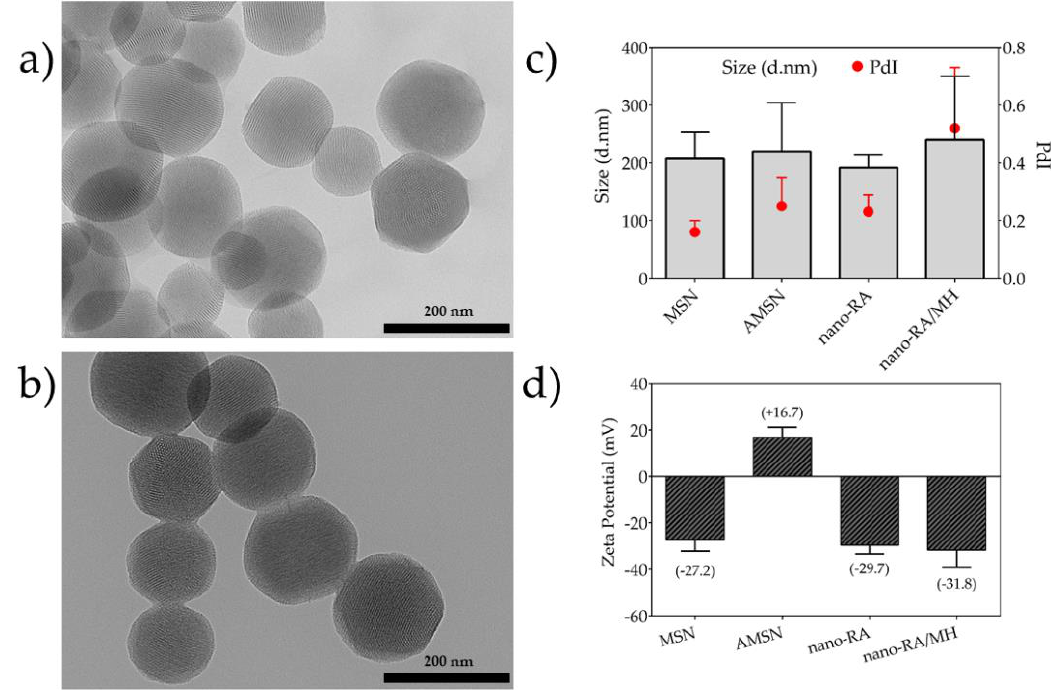
Figure 2. Transmission electron microscopy (TEM) micrographs and particle size distribution. ( a ) TEM image of bare mesoporous silica nanoparticles (MSN), ( b ) TEM image of rosmarinic acid–functionalized silica nanocarrier (nano-RA), ( c ) hydrodynamic diameter and polydispersity index (PdI) of nanomaterials by dynamic light scattering (DLS) measurement, and ( d ) zeta potential of nanomaterials.